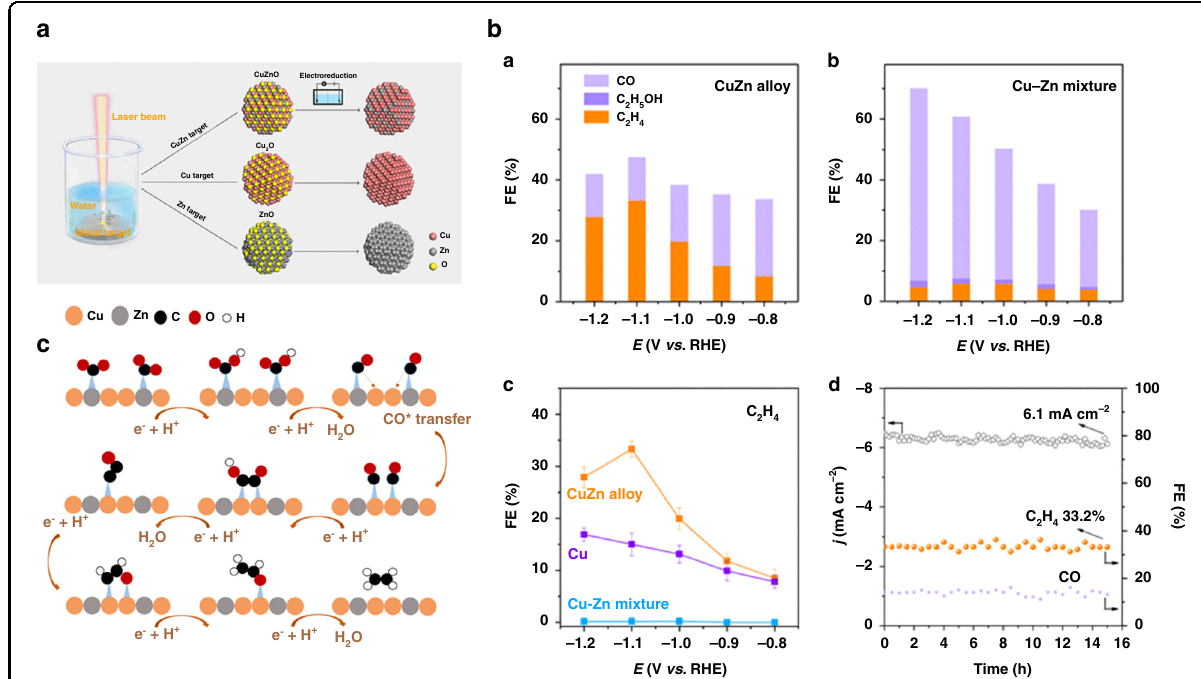
Fig. 17 PLA assisted synthesis of CuZnO, ZnO, and Cu 2 O for electrochemical reduction of CO 2 . a Schematic design for the production of CuZnO, ZnO, and Cu 2 O using PLA in water followed by electroreduction. b( a – c) Faradaic ef fi ciency (FE) values of the electroreduction of CO 2 into value-added products over various catalysts, b( b – d) Current density and FE of CO and ethylene over CuZn alloy at – 1.1 V vs RHE for 15 h, and c CO